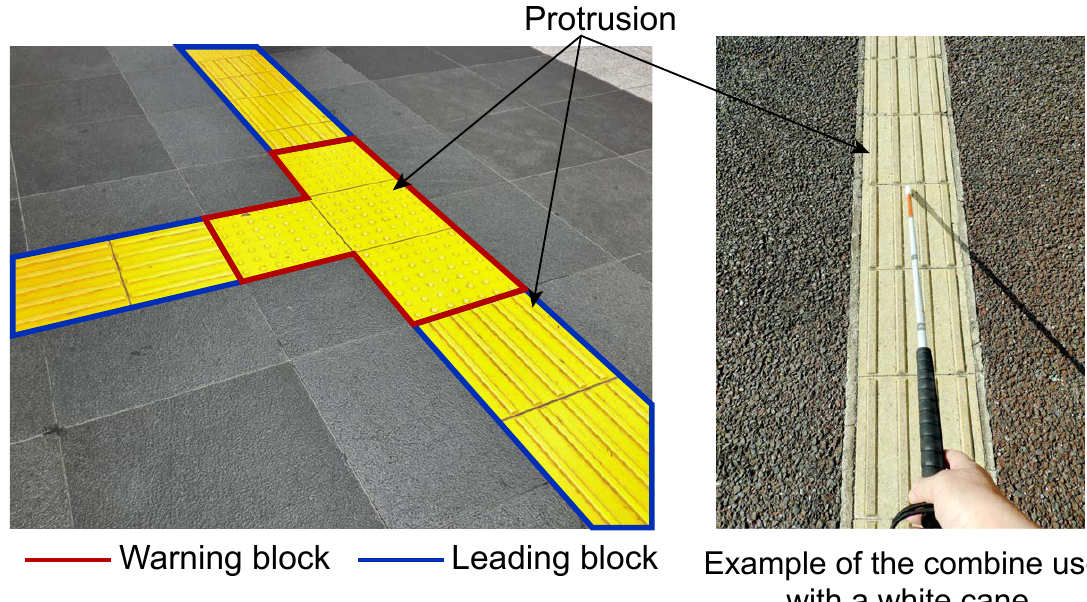
Figure 2. There are two types of braille blocks: leading blocks and warning blocks. The leading block is installed so that a visually impaired people can follow the direction indicated by the protrusion while checking them with the sole of the foot or a white cane. The warning block is a block indicating a position to be noted. It is installed in front of stairs, in front of pedestrian crossings, in front of information boards, in front of obstacles,